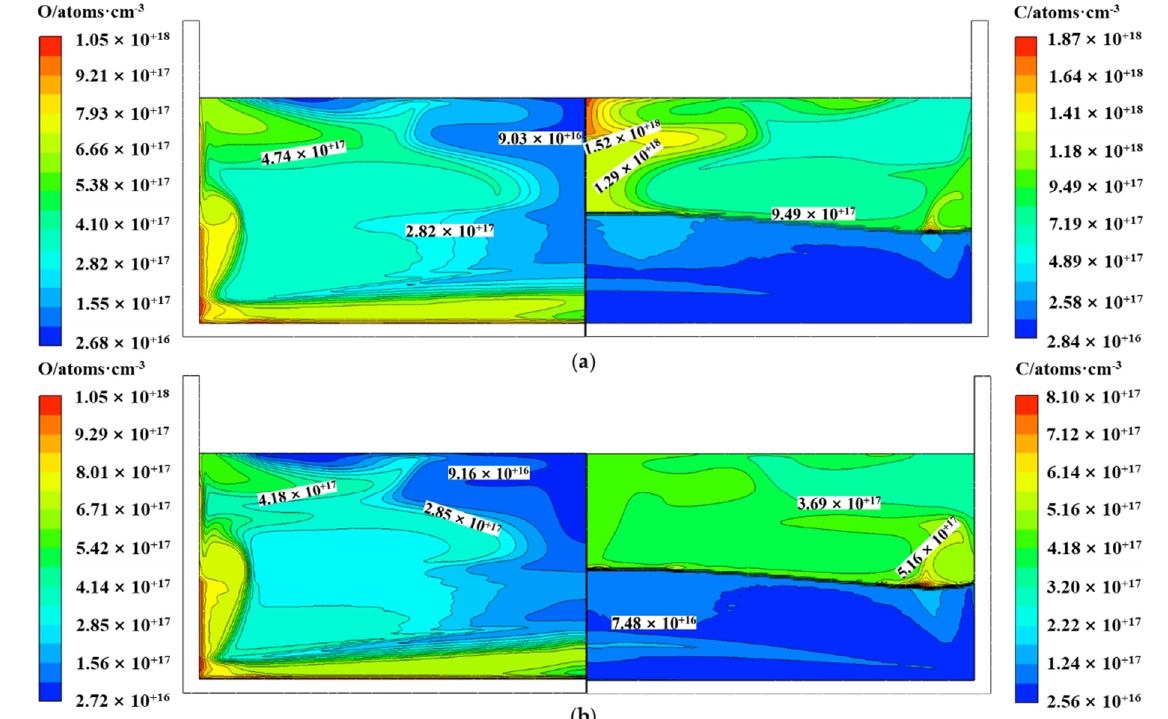
Figure 9. The concentration distributions of O and C in the silicon melt and crystal without ( a ) and with ( b ) the AGDS at the 50% crystalline fraction.